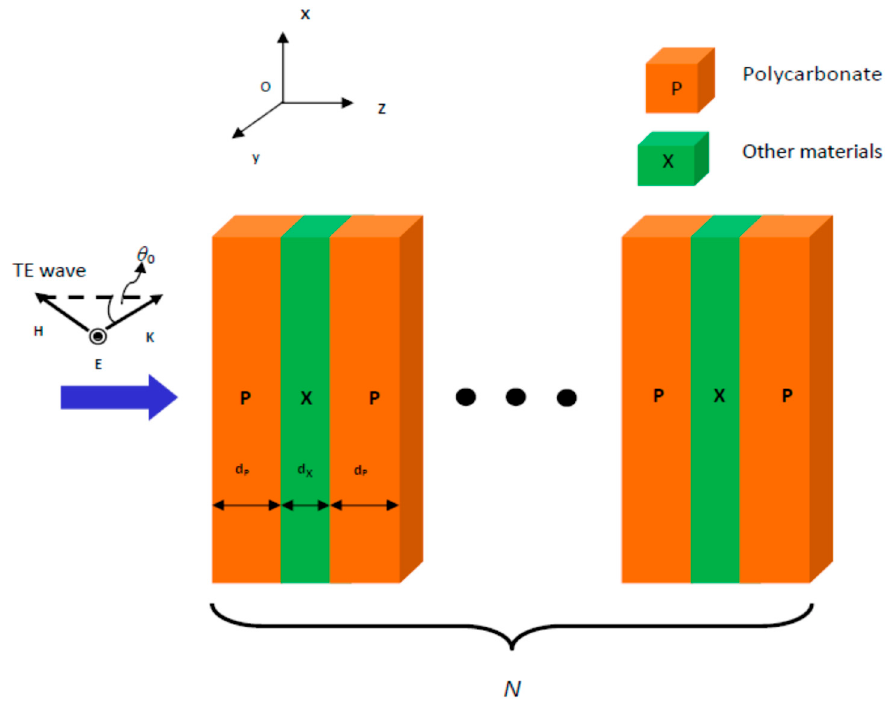
Figure 1. The schematic design of 1D ternary photonic structures considered in this work. Here, the letters P and X are being used to represent polycarbonate and other material layers (Al 2 O 3 , TiO 2 , MgF 2 and BaF 2 ) of thickness d p and d x , respectively.